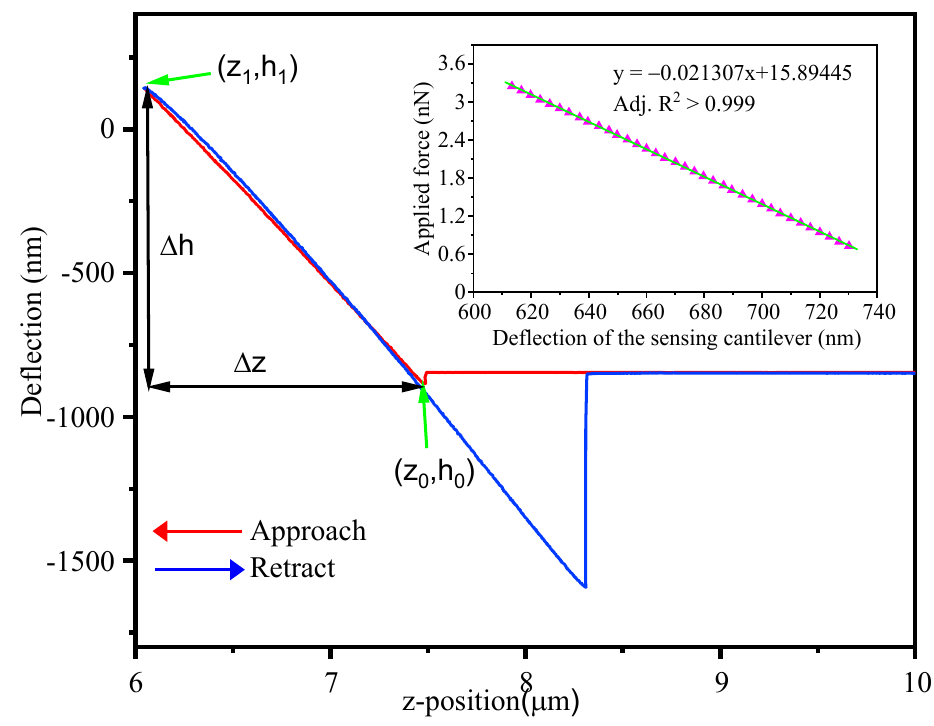
Figure 5. The correlation between the microcantilever deflection and the AFM tip displacement, The red approach curve is used for calculation. Inset is the relationship between the applied force and the deflection of the sensing microcantilever.